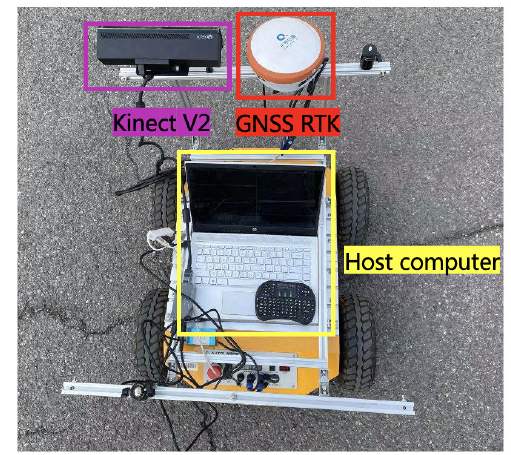
Figure 8. Experimental platform.